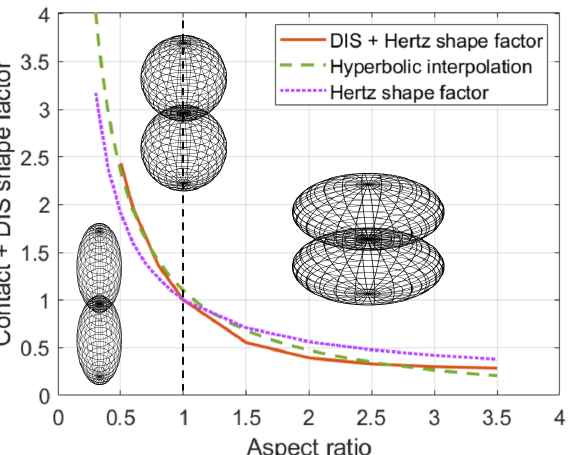
Figure 12. Overall shape factor computed as the ratio of maximum Von Mises stress in ellipsoid and in sphere (red line). Hyperbolic interpolation of the overall shape factor is reported in green dashed line. The “only contact” shape factor is reported in dotted purple